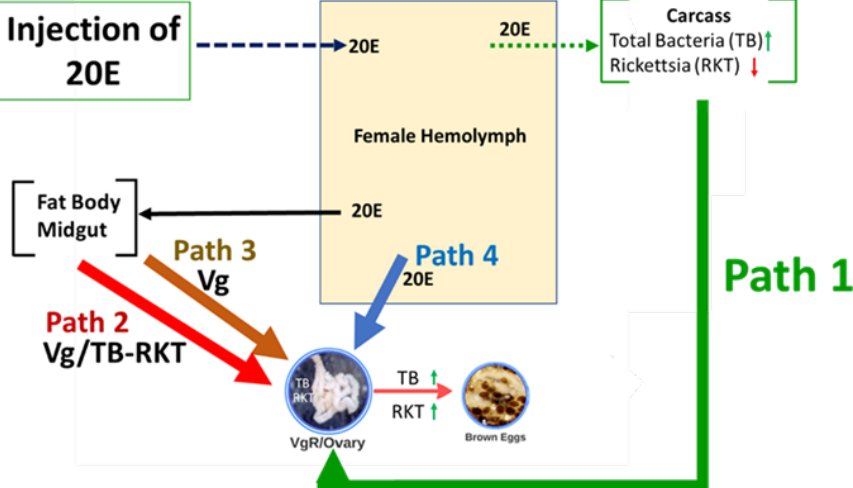
Figure 6. Possible mechanisms for ecdysteroid signaling affecting the microbiome in part-fed, virgin adult Dermacentor variabilis . The up and down arrows are indicating changes in bacteria density associated with 20E injection. 20E, 20-hydroxyecdysone; Path, pathway; Vg, vitellogenin; VgR, Vg receptor; Vn, vitellin.